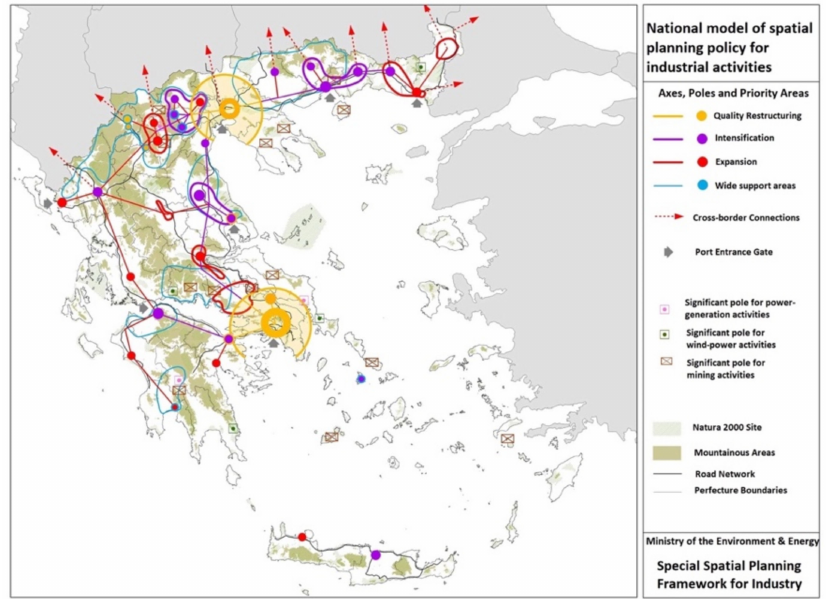
Figure 2. Special Spatial Planning Framework for Industry (SSPFI), Greece. Source: Greek Govern- ment Gazette 151/AA Π /2009